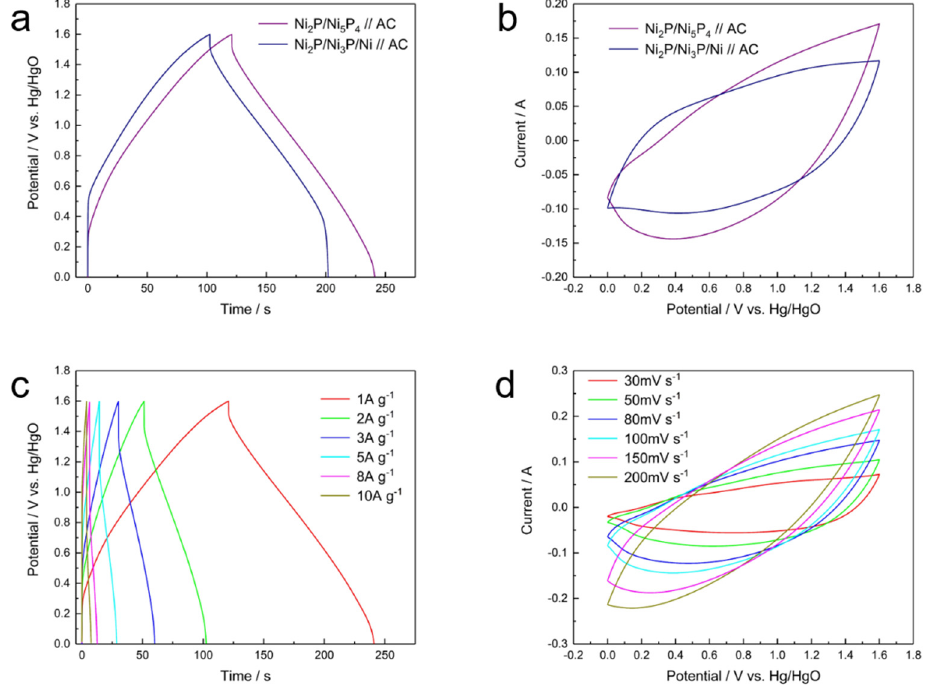
Figure 9. The electrochemical test graph of the assembled supercapacitors. ( a ) Galvanostatic charge- discharge curves of Ni 2 P/Ni 3 P/Ni//AC and Ni 2 P/Ni 5 P 4 //AC supercapacitors at a current density of 1 A g − 1 . ( b ) Cyclic voltammetry curves of Ni 2 P/Ni 3 P/Ni//AC and Ni 2 P/Ni 5 P 4 //AC supercapacitors at a scan rate of 100 mV s − 1 . ( c , d ) Galvanostatic charge-discharge curves of Ni 2 P/Ni 5 P 4 //AC supercapacitor under various current densities and cyclic voltammetry curves of Ni 2 P/Ni 5 P 4 //AC supercapacitor at various scan rates.